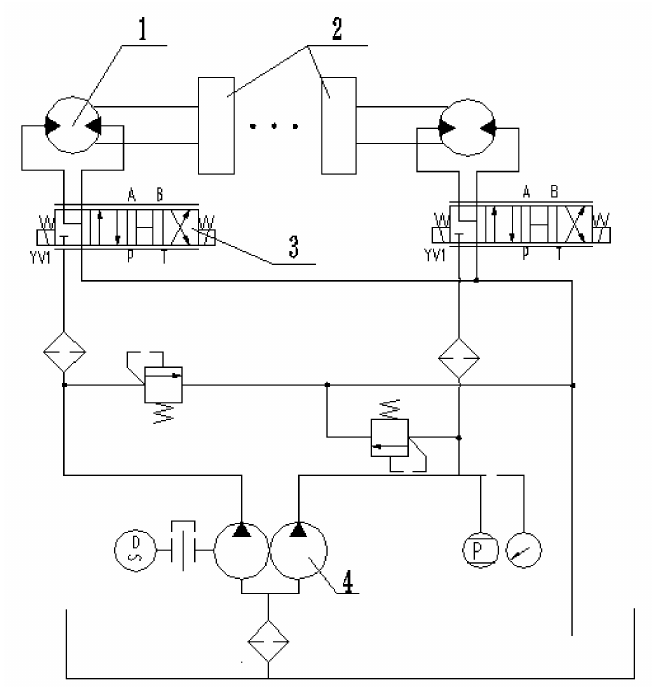
Figure 1. Structural Diagram for Double pump-double valve-controlled Motor System. (1. Motor 2. Load 3. Servo valve 4. Double